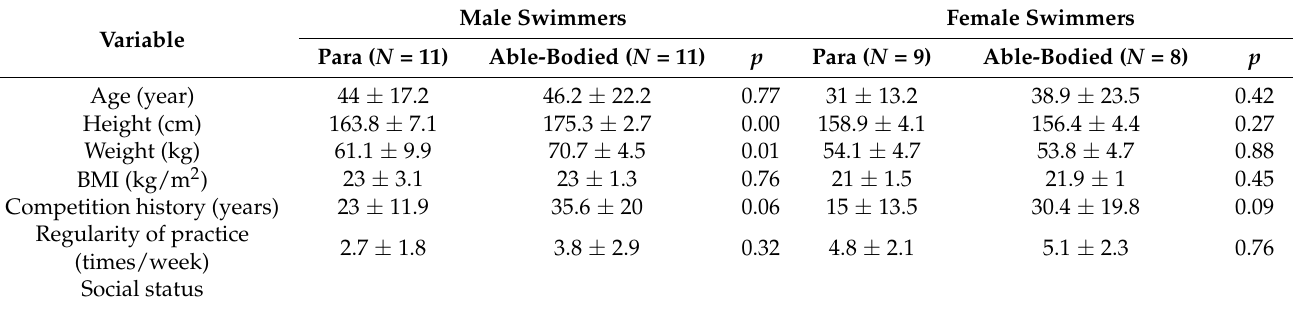
Table 1. Participants’ demographics and baseline ( N =